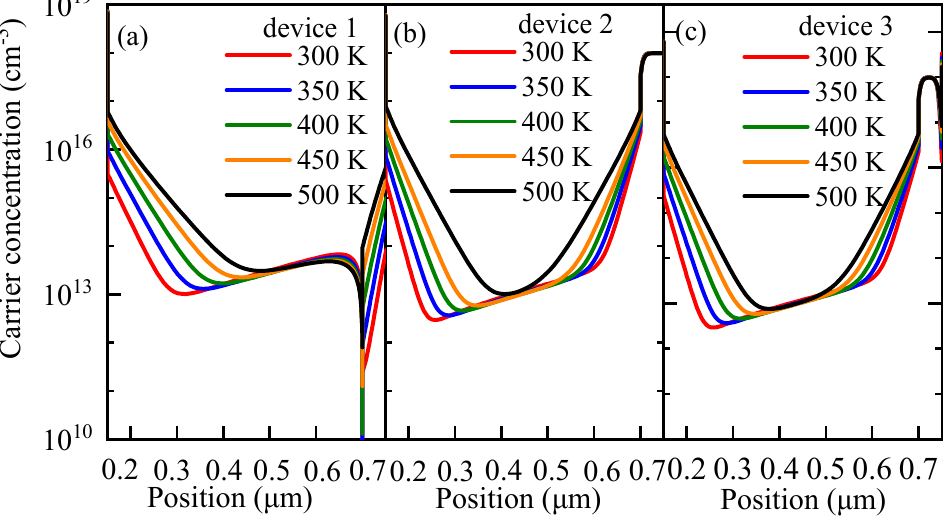
Figure 22. Effects of temperature on the carrier concentration: ( a ) carrier concentration of device 1 at different temperatures, ( b ) carrier concentration of device 2 at different temperatures, ( c ) carrier concentration of device 3 at different temperatures. In Figure 23a, the red and the blue lines represent the J-V characteristic curves at 300 and 500 K, respectively. The filled area between the red and blue lines represents the differences between the two curves. It can be observed that, when T increases from 300 to 500 K, the change in the J-V characteristic curves of device 1 is the largest, while that of device 3 is the smallest. Similarly, Figure 23b shows that the temperature change has the greatest impact on the carrier recombination of device 1 and the least impact on device 3 (the red and the blue lines represent the total recombination curves at 300 and 500 K, respectively). When T changes from 300 K to 500 K, the largest change is observed in V oc of device 1, while the least change is found in V oc of device 3. The variation of V oc is influenced by carrier recombination. Figure 21 shows that the carrier recombination change of device 1 is more obvious than that of device 3. As a result, the change of V oc in device 1 is more significant. Figure 20 shows that the FF of the device decreases as the temperature increases. In comparison, the FF change of device 1 is the largest, while that in device 3 is the smallest. FF measures the series resistance of the device. Therefore, it can be inferred that the series resistance change in device 1 is the largest, while that in device 3 is the least. Photovoltaic characteristics can be represented by J-V characteristic curves, which contain key information such as V oc , J sc , FF , and PCE . Thus, the most significant changes in V oc and FF of device 1 result in the most notable variations in its J-V characteristics curve. It can be calculated from Figure 23c that the PCE values of device 1, device 2, and device 3 decrease by 94%, 61%, and 52%, respectively, as T is gradually increased from 300 K to 500 K. Device 3 has the least performance degradation. All these results indicate that device 1 is most sensitive to the temperature change, while device 3 maintains the highest stability under the changing